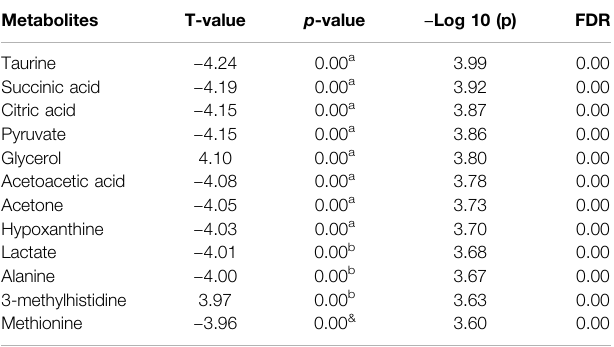
TABLE 3 | Metabolites showing signi fi cant differences between backcourt and frontcourt players in the post-game samples during elite male basketball. Metabolites